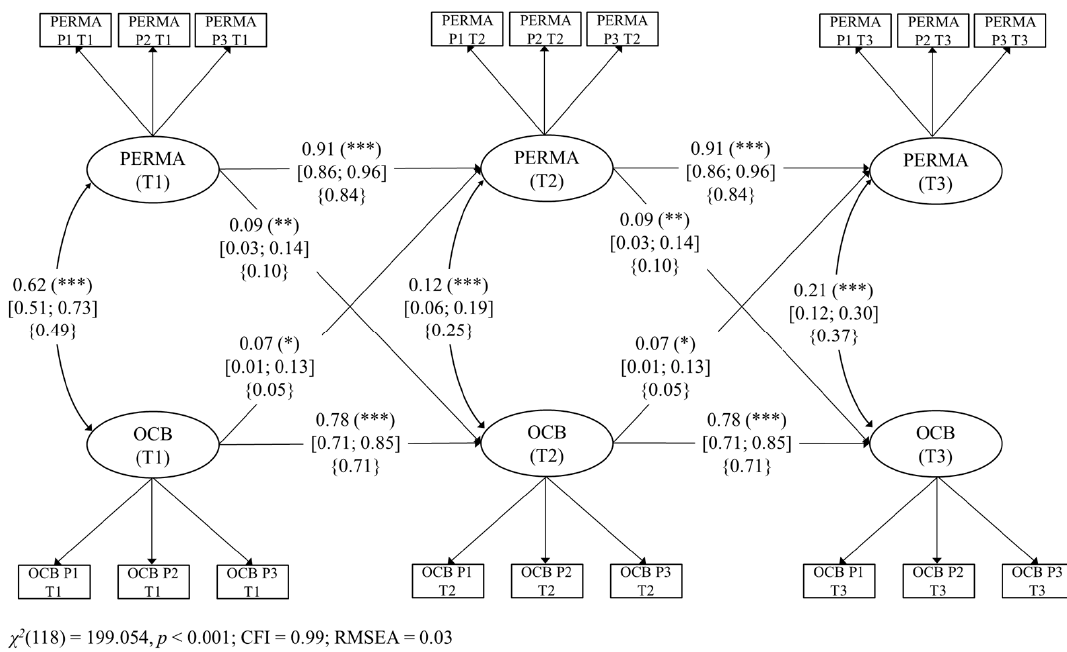
Figure 3. Model 3. Structural longitudinal model for the associations between PERMA and organizational citizenship behaviors (OCBs). Coefficients shown are unstandardized paths. The unstandardized confidence intervals are reported in square brackets for significant paths. Standardized paths are shown in curly parentheses. Error terms and loadings are not shown to enhance visual clarity. P1: Parcel 1, P2: Parcel 2, and P3: Parcel 3. T1: Time 1, T2: Time 2, and T3: Time 3. Solid lines = significant paths. *** p < 0.001; ** p < 0.01; * p < 0.05.